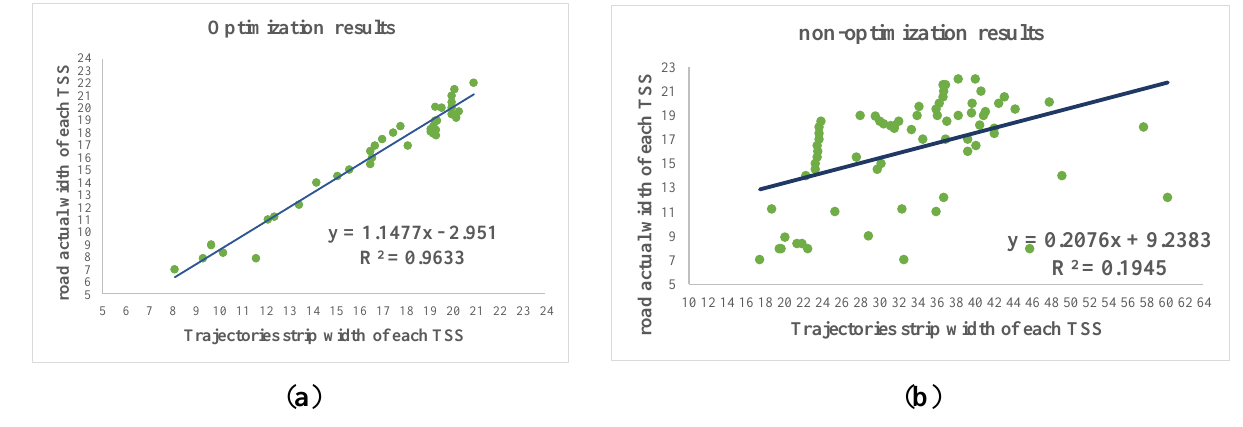
Figure 13. Optimization results evaluation: ( a ) shows the evaluation results of optimized trajectories; ( b ) indicates the evaluation results of non-optimized